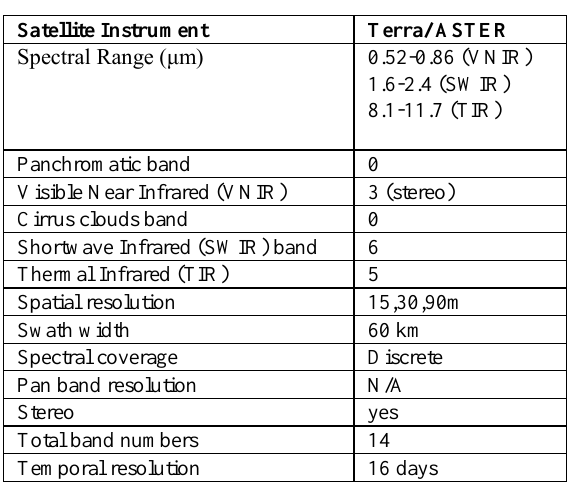
Table 1. ASTER data